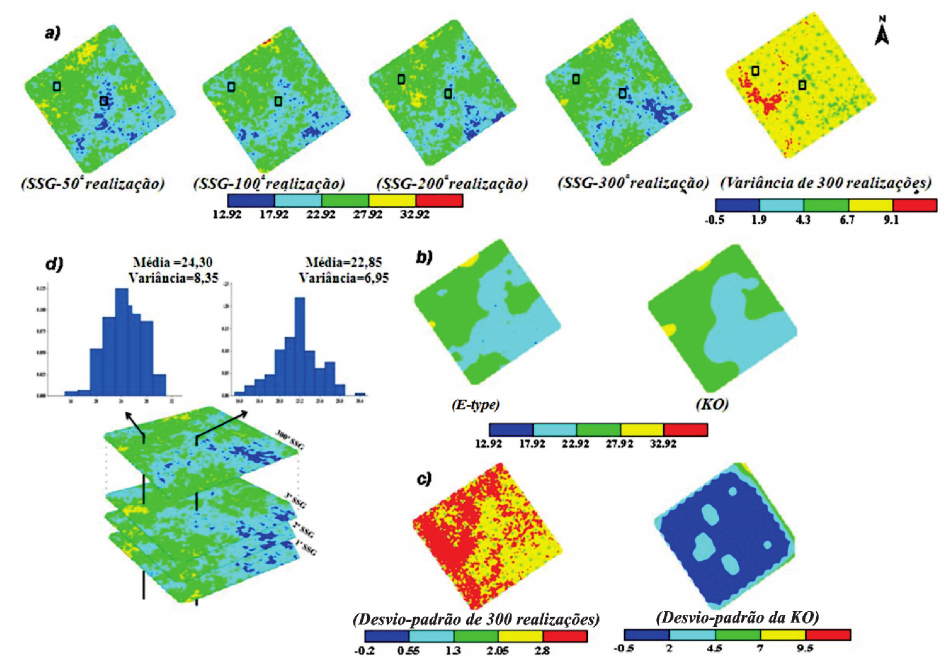
Teor de goethita, g kg -1 - Pedoforma